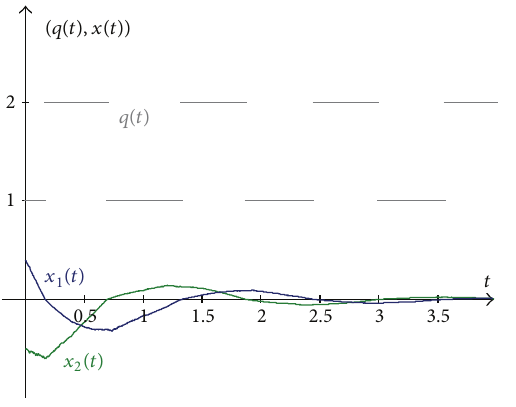
Figure 5: Simulation of the hybrid system (53) with stabilizing for 𝑝 = 1 switching 𝜎 = 𝜎 st